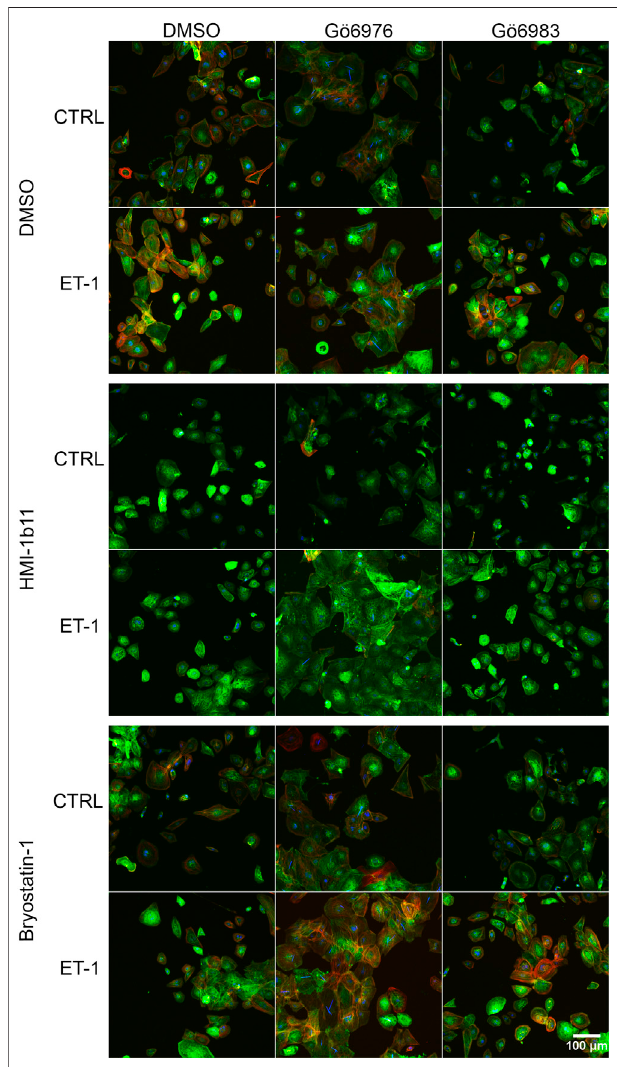
FIGURE 6 | | Effects of endothelin-1 (ET-1) and pharmacological PKC modulation on human induced pluripotent stem cell-derived cardiomyocyte (hiPSC-CM) morphology. Representative images of immuno fl uorescence stainedhiPSC-CMs(D33)treatedwithPKCactivators(10 µMHMI-1b11 and 10 nM bryostatin-1), cPKC inhibitor (1 µM Gö6976) and pan-PKC inhibitor (1 µM Gö6983) with or without 100 nM ET-1 for 48 h (blue (cid:2) DAPI, green (cid:2) α -actinin, red (cid:2) F-actin).